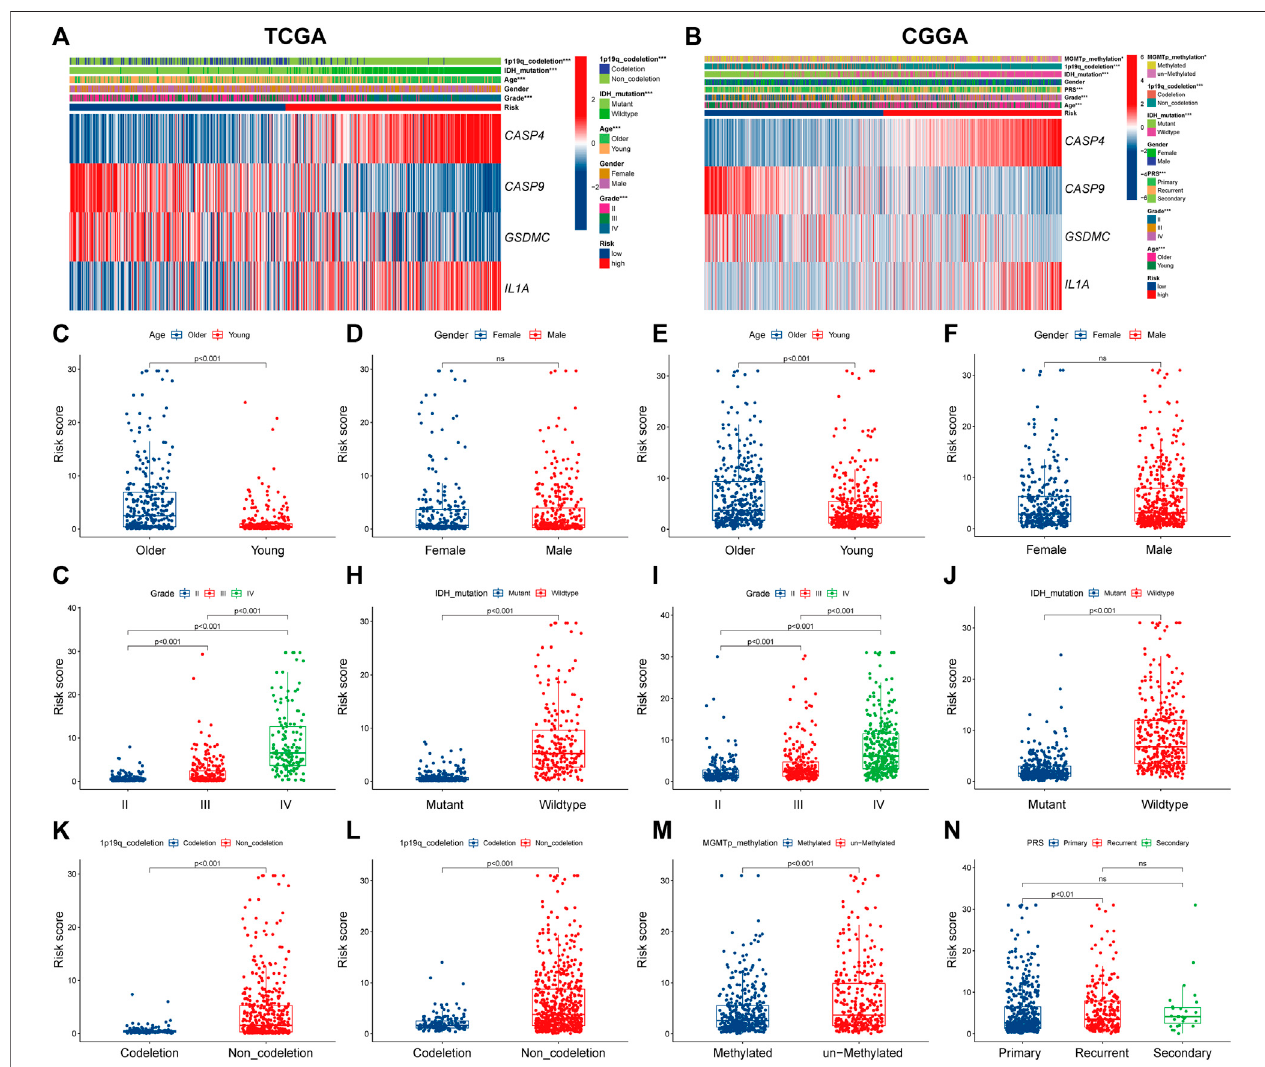
FIGURE 5 | The correlation between PRGs risk score and clinicopathologic characteristics. (A,B) Heatmap of correlation between PRGs risk groups with age, gender, tumor grade, IDH status, 1p19q codeletion, and PRGs signature gene expression in TCGA dataset (A) , and age, gender, tumor grade, IDH status, 1p19q codeletion, MGMT promoter methylation status, PRS type, and PRGs signature gene expression in CGGA dataset (B) . (C – N) Box and scatter plot of relationship between risk score and age (C) , gender (D) , tumor grade (G) , IDH status (H) , and 1p19q codeletion (K) in TCGA dataset; and age (E) , gender (F) , tumor grade (I) , IDHstatus (J) ,1p19qcodeletion (L) ,MGMTpromotermethylationstatus (M) ,andPRStype (N) inCGGAdataset,respectively.PRGs,PyroptosisRelatedgenes.TCGA, The Cancer Genome Atlas. CGGA ， Chinese Glioma Genome Atlas. IDH, isocitrate dehydrogenase. MGMT, O6-methylguanine-DNA methyltransferase. PRS, tumor type of primary recurrent or